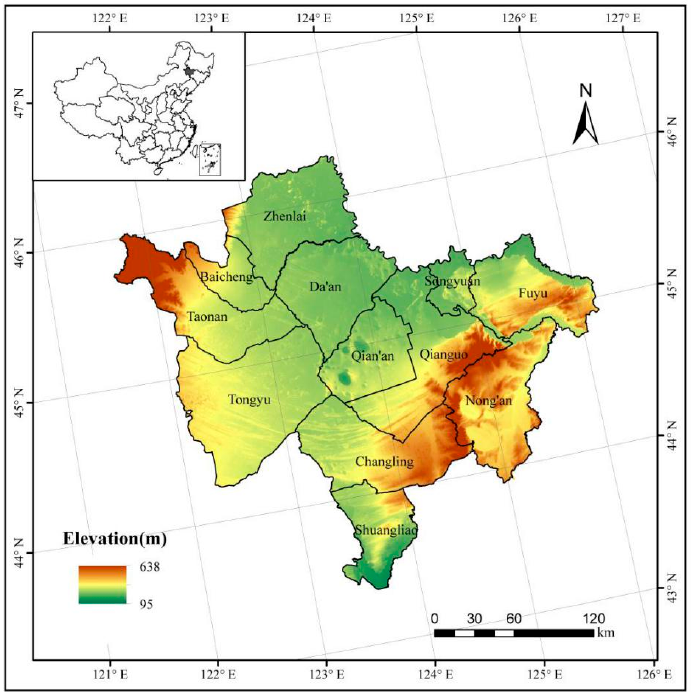
Figure 1. Location of Western Jilin, China.